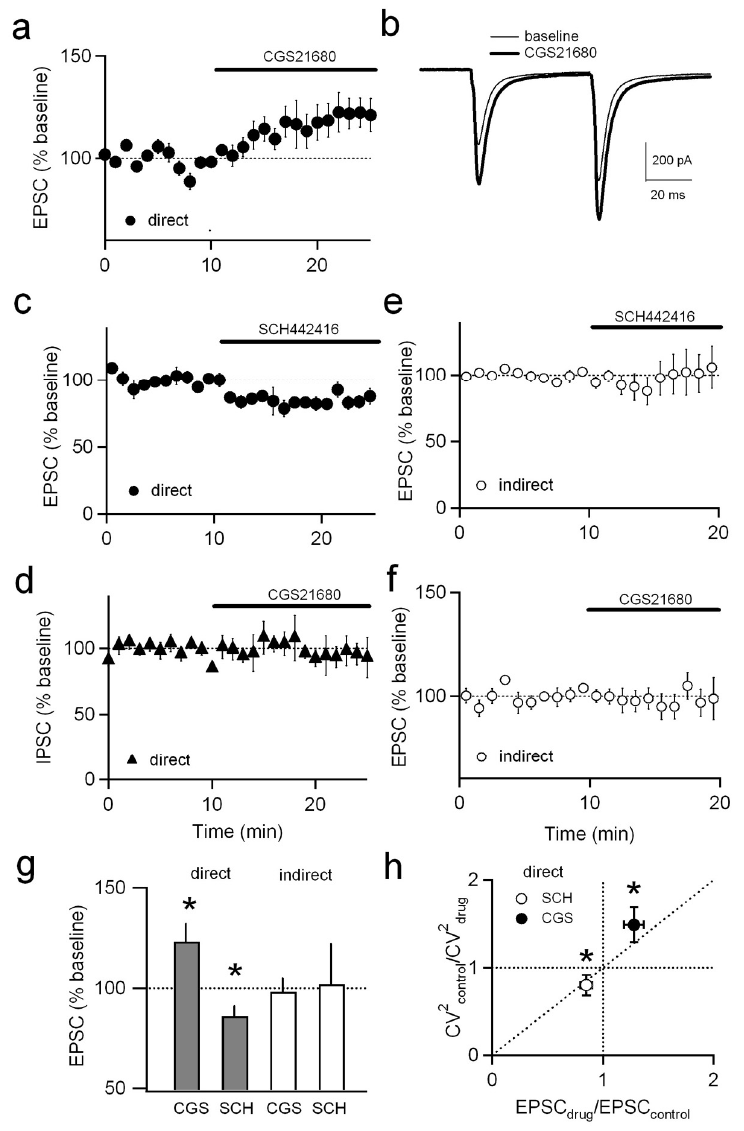
FIGURE 6. A 2A receptor activation enhances glutamatergic transmission at direct- pathway striatal GABAergic efferent neurons. (a) Normalized mean EPSC amplitudes recorded from direct-pathway MSNs were significantly enhanced by CGS21680 (1 µ M ) (n = 7, p < 0.05). (b) Average traces recorded at baseline (thin line) and after CGS21680 bath application (thick line). (c) The A 2A receptor antagonist SCH442416 (1 µ M ) significantly decreased EPSC amplitude (n = 6, p < 0.05) at direct-pathway MSNs. (d) CGS21680 did not alter IPSC amplitudes (n = 5, p > 0.05). (e) SCH442416 had no effect on normalized mean indirect-pathway EPSC amplitude (n = 5, p > 0.05). (f) CGS21680 had no effect on normalized mean indirect-pathway EPSC amplitude (n = 5, p > 0.05). (g) Summary of EPSC modulation by CGS21680 (CGS) and SCH442416 (SCH) at 20–25 min (direct pathway) or 15–20 min (indirect pathway) after drug application. (h) Mean-variance analysis of direct-pathway EPSCs following drug application (20–25 min). Asterisks denote p < 0.05. Results are expressed as mean ±